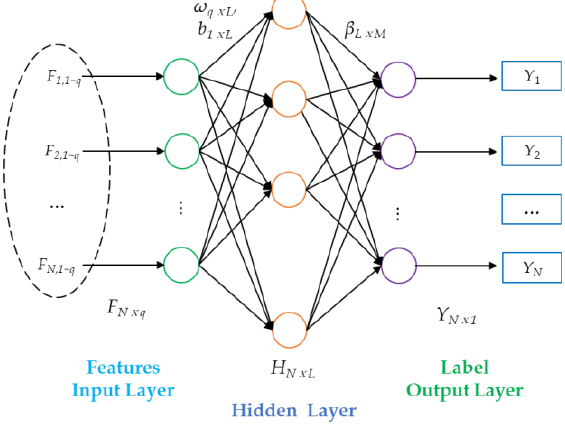
Figure 3. Network model of the extreme learning machine.